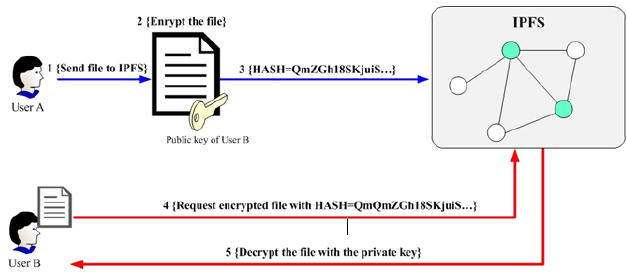
Table 4. Review of blockchain use cases in